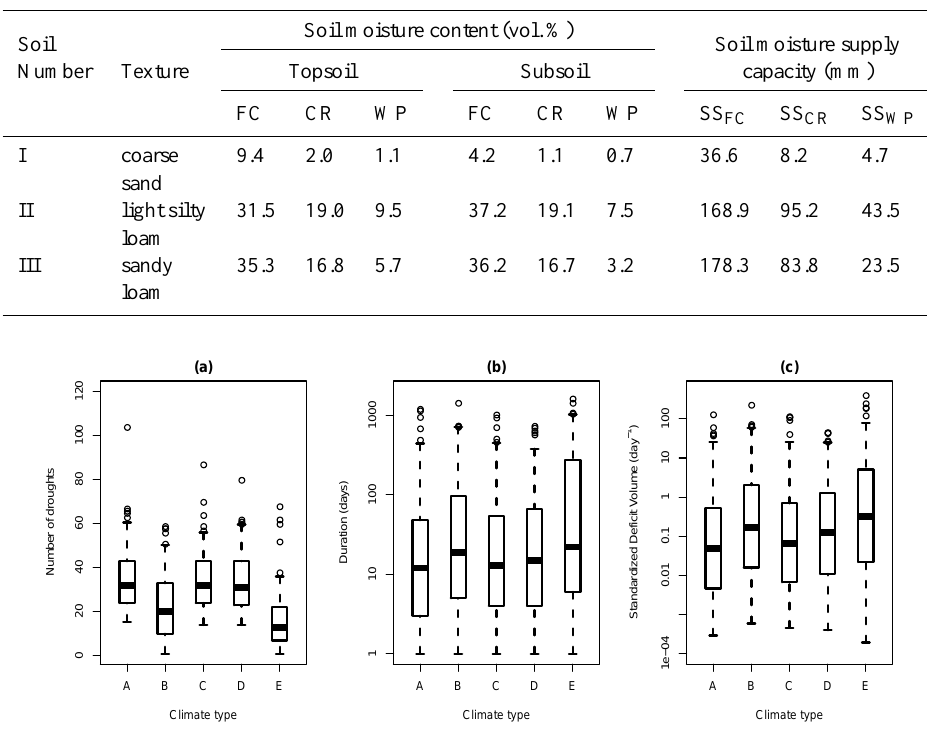
Soil moisture content (vol.%)